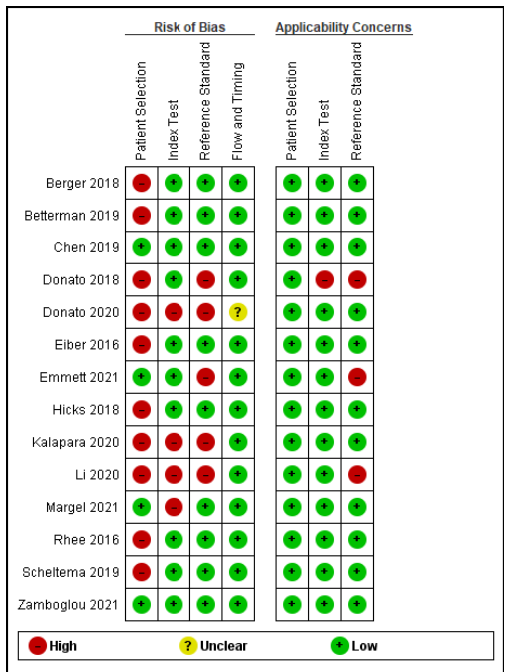
Figure 4. QUADAS-2 score indicates the risk of bias analysis in assessing the low, high, or unclear risk for patient selection, index test, reference standard, flow, and timing for individual studies. An add-on analysis on applicability concerns is also included.